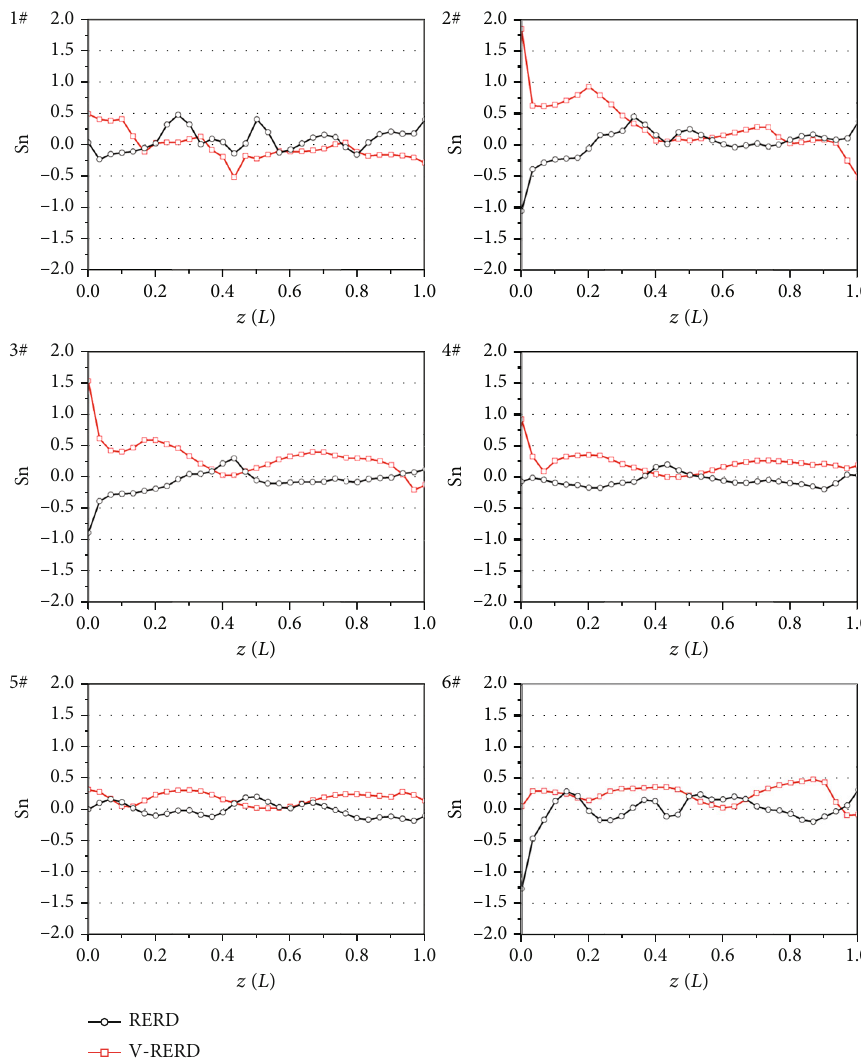
Figure 10: Variation of swirl number in the